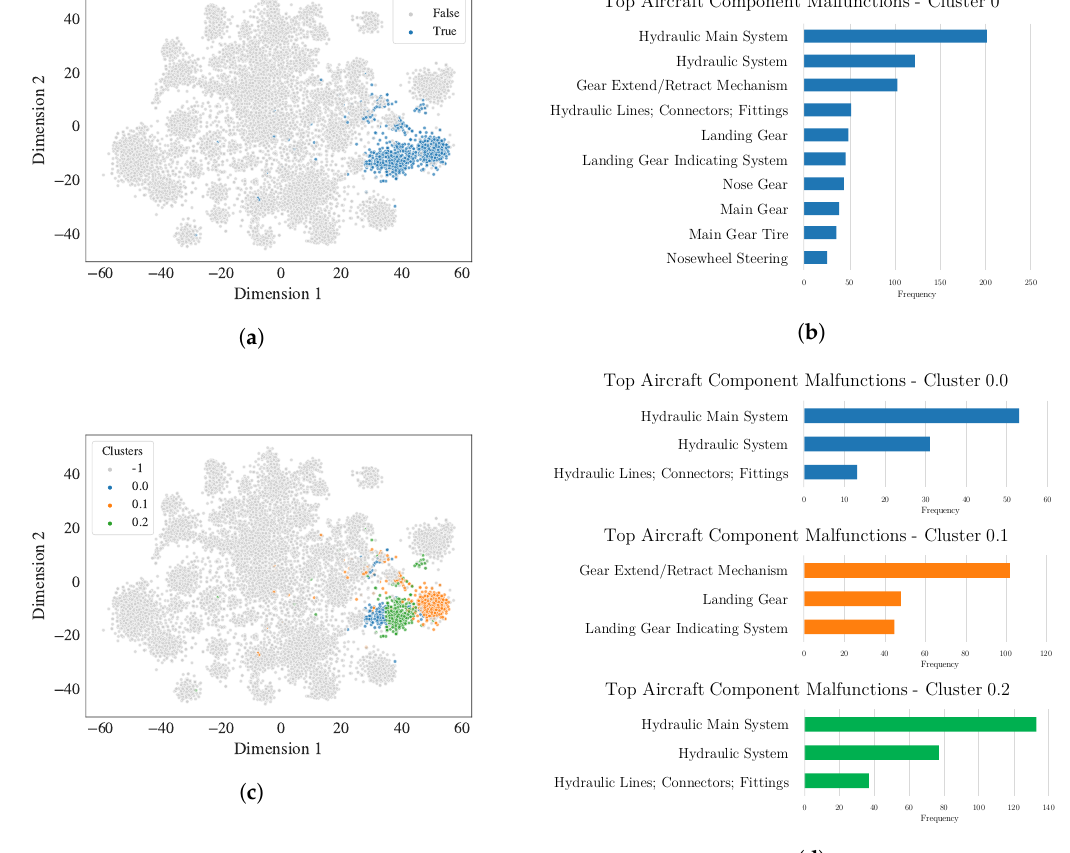
Figure 4. Highlight of cluster 0 and its sub-clusters, including most common aircraft component malfunction metadata plots. ( a ) Highlight of Cluster 0. ( b ) Cluster 0 Aircraft Component. ( c ) Highlight of Cluster 0 Sub-Clusters. ( d ) Sub-Cluster Aircraft